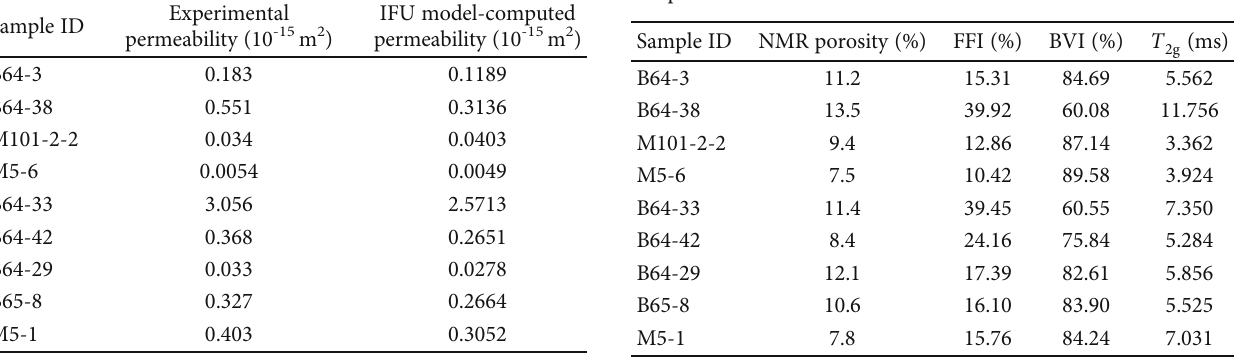
Table 2: Results of IFU model-computed permeability. Table 3: Parameters of the NMR experiment of some typical